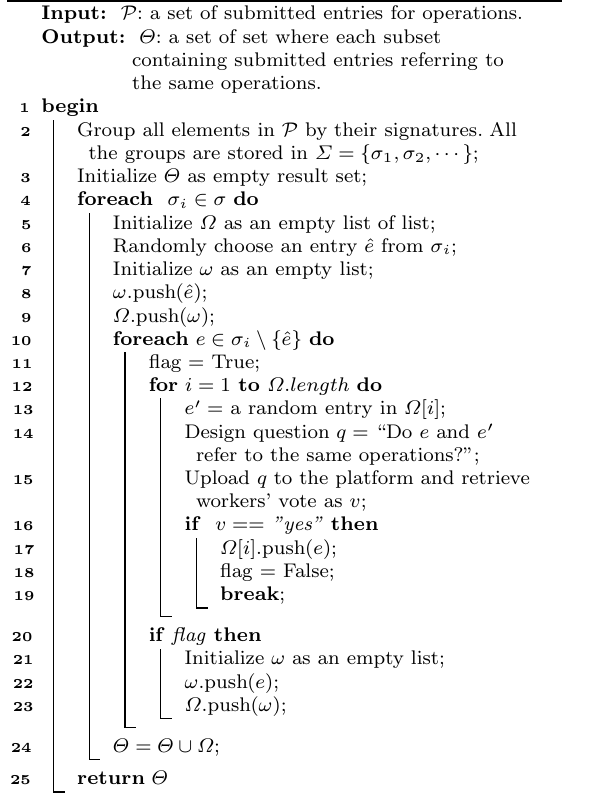
Algorithm 1: HandlingDuplicatedOperations (